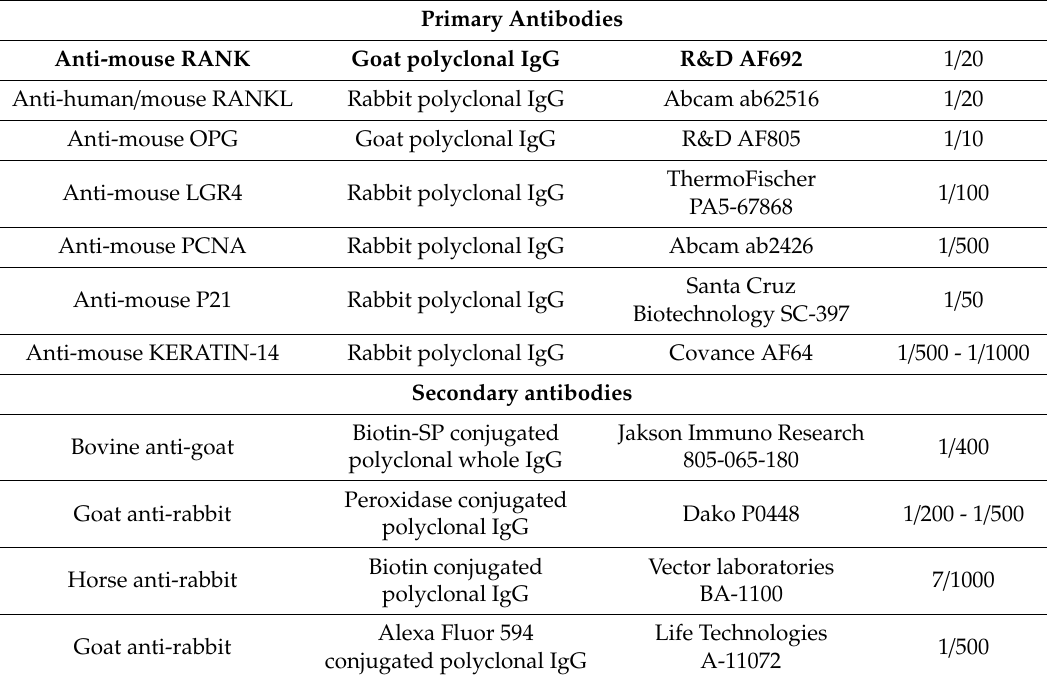
Table 4. Primary and secondary antibodies and conditions of